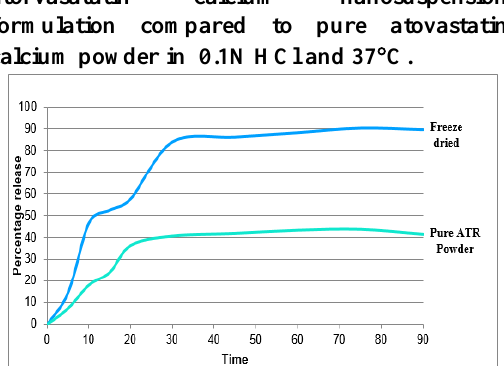
Figure 8. Release profile of freeze dried atorvasatatin calcium nanosuspension